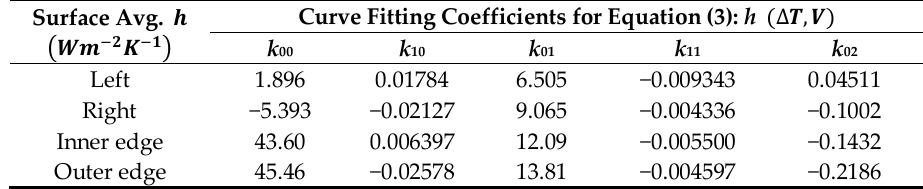
Table 2. Curve fits for the average convective heat transfer coefficient of individual disc surfaces resulting from the CFD model, as a function of bike velocity (cid:1848) (m/s) and temperature difference between the surface and freestream ∆(cid:1846) = (cid:1846) (cid:3031)(cid:3036)(cid:3046)(cid:3030) − (cid:1846) (cid:2998) in degrees K. Surface Avg.